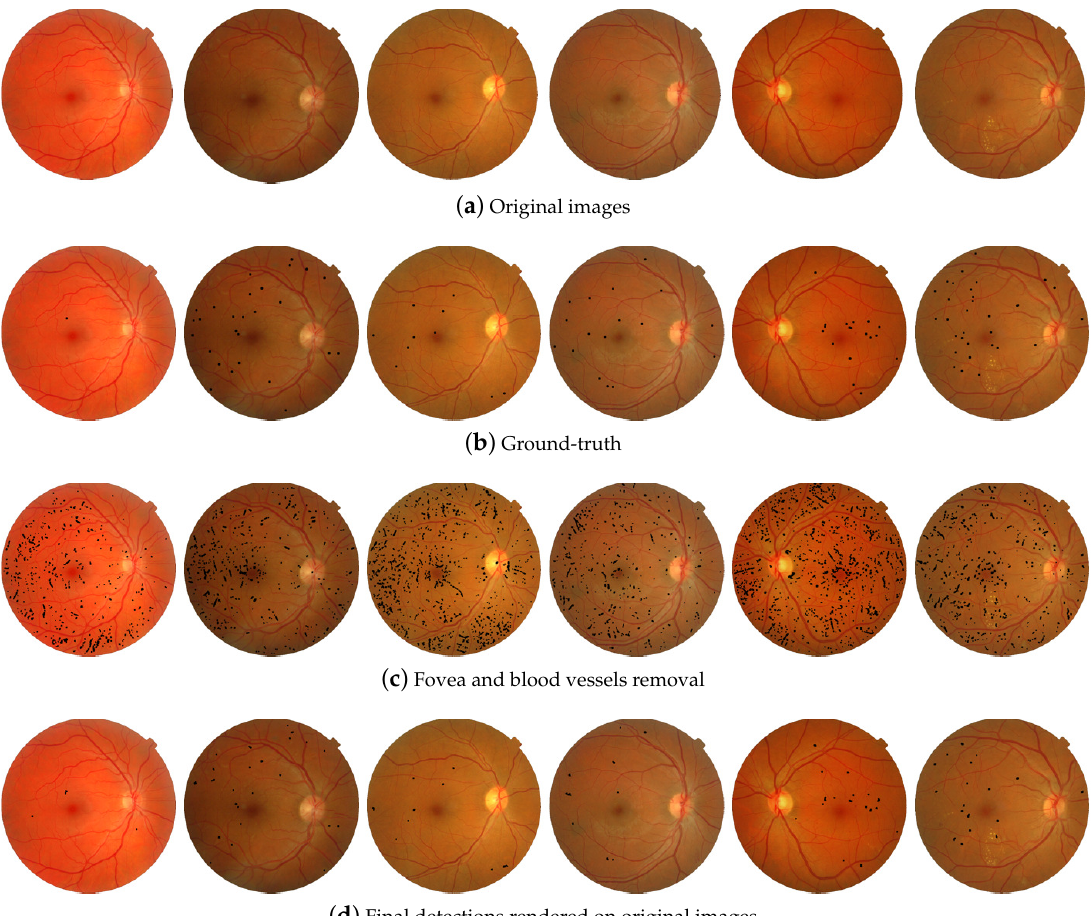
Figure 11. Microaneurysms detection using proposed